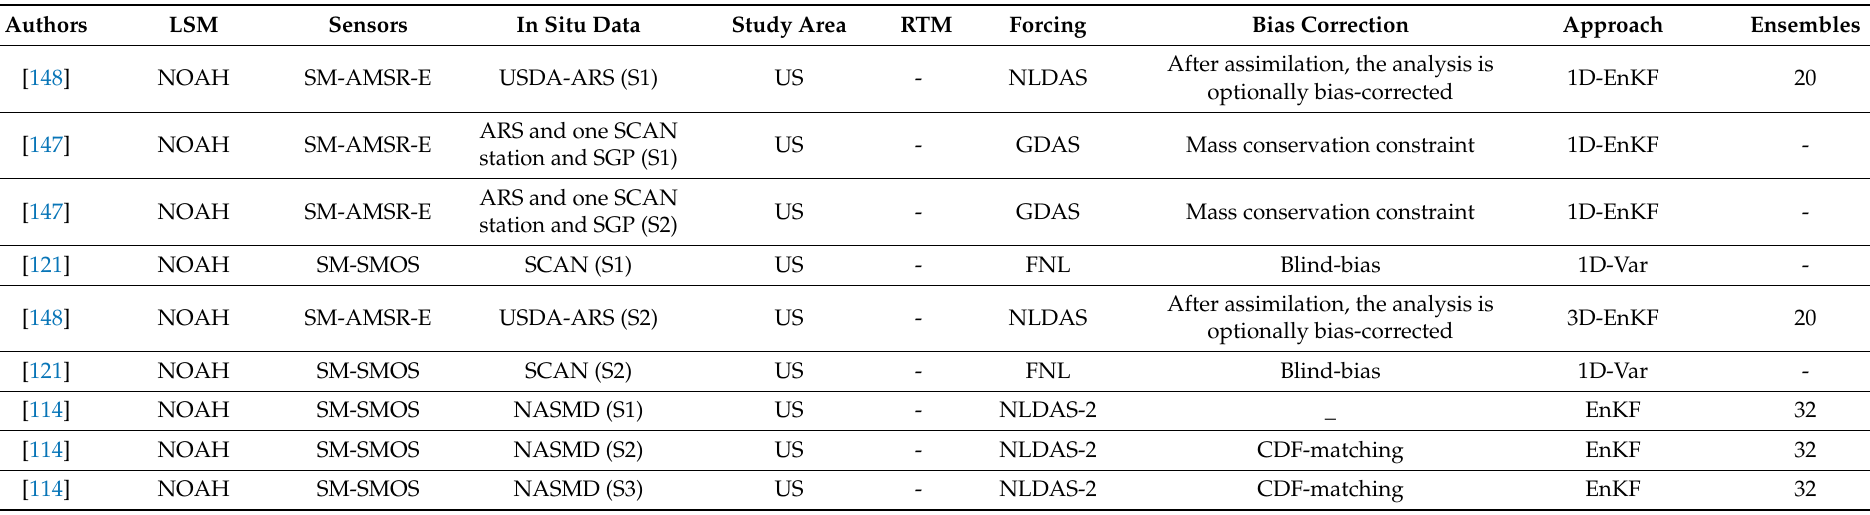
Table 5. Bias improvements in SSM with biases of less than − 0.023 (m3 m-3) for papers reviewed in this study.